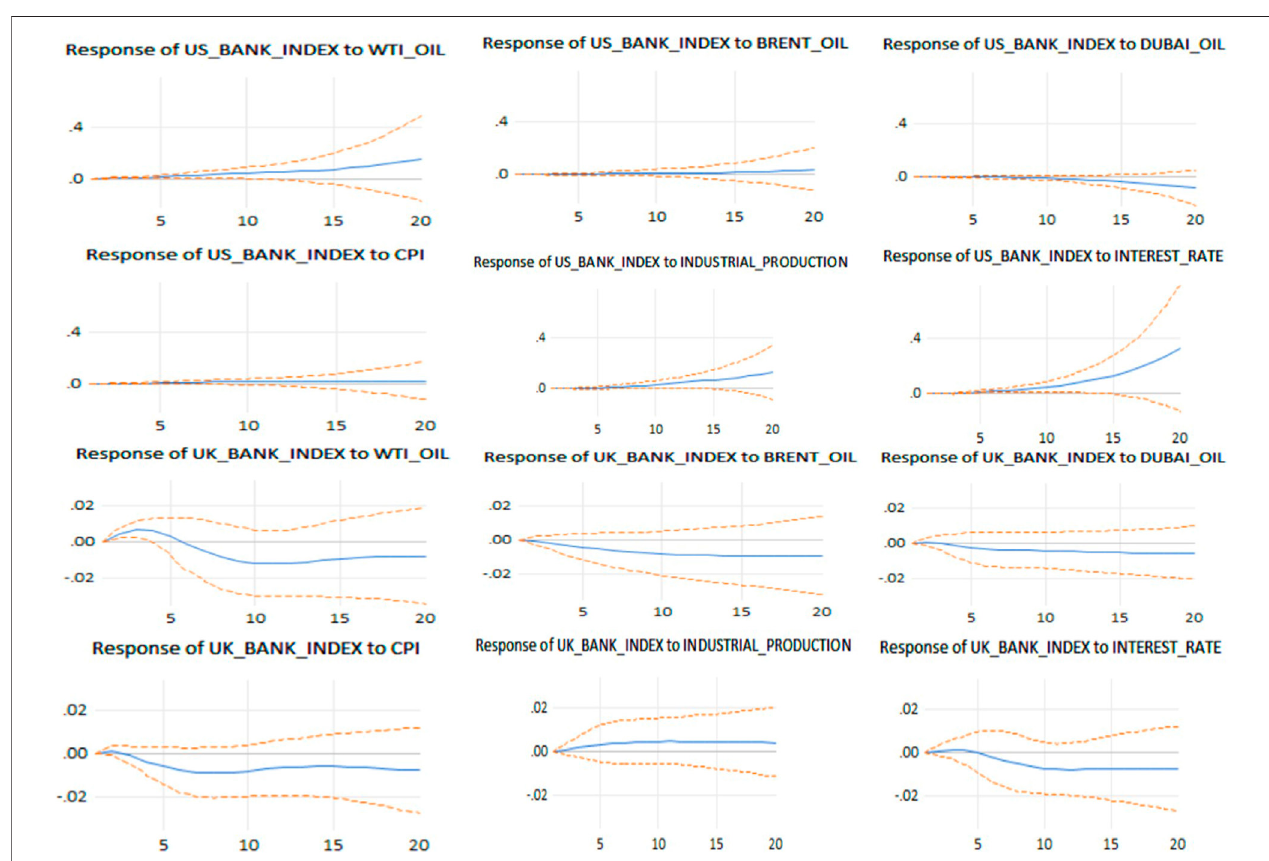
FIGURE 1 | Impulse response function analysis: the US, the